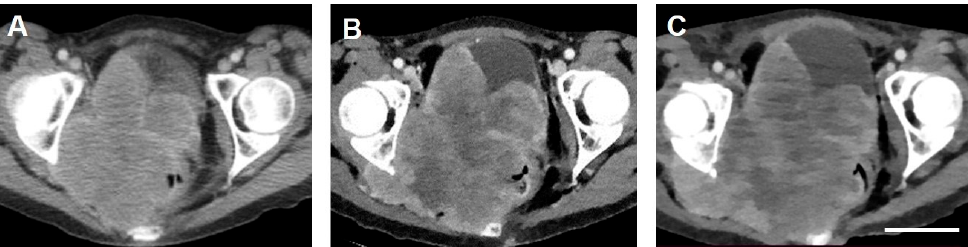
Figure 3. Transverse computed tomographic images of the Stage IIB carcinoma of the cervix obtained from the patient before ( A ) and 3 ( B ) and 21 days ( C ) after treatment with TOL. The images were chosen to depict cuts through the tumor at levels as closely similar as possible. Adjustments of magnifications were made to match the dimensions of bony landmarks of the femoral head and acetabulum. Adjustments of contrast and brightness for optimum clarity of the images were applied equally to all the three images. Note that the size of the tumor increases with each successive image. By contrast-enhanced CT, areas of hypodensity observed within the tumor mass appear larger and much more prominent after treatment with TOL, consistent with the reduction in measured tissue densities from 70 HU pre-treatment ( A ) to 56 HU ( B ) by day 3 and 47 HU ( C ) by day 21 post-treatment. Additional region-of-interest (ROI) reference measurements were made for each scan over the left gluteal musculature revealing values of 127 HU ( A ), 120 HU ( B ) and 125 HU ( C ), respectively. Calibration bar in C = 5 cm.